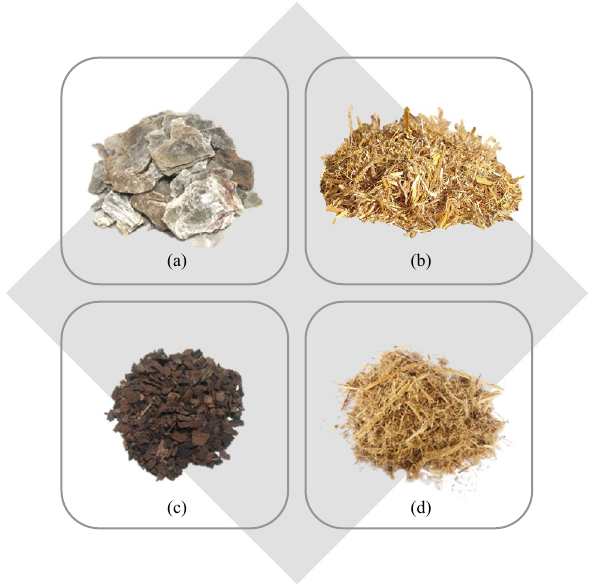
Fig. 2 Types of LCM; a Mica. b Wheat Straw. c Oak Shell. d Sugar- cane Bagasse Fiber or